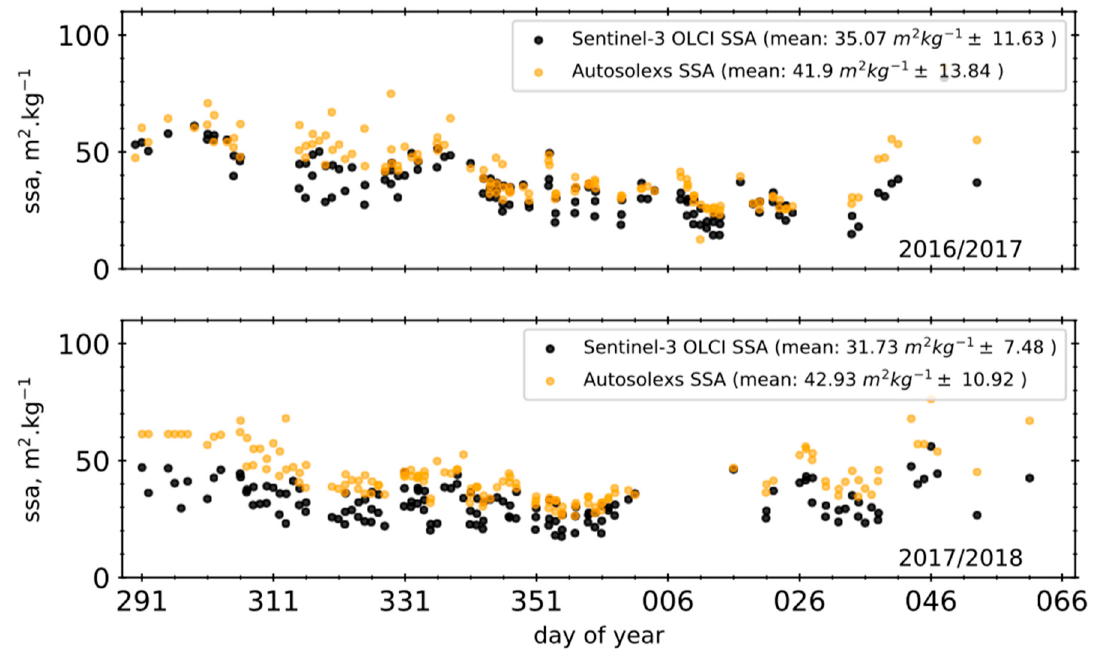
Figure 16. Time series of SSA calculated using the Autosolexs spectral albedo measurements, and the Sentinel-3 OLCI spectral planar albedo retrievals over Dome C for the 2016/17 and 2017/18 summer seasons. The gaps in the time series are due to periods of time with cloud cover.